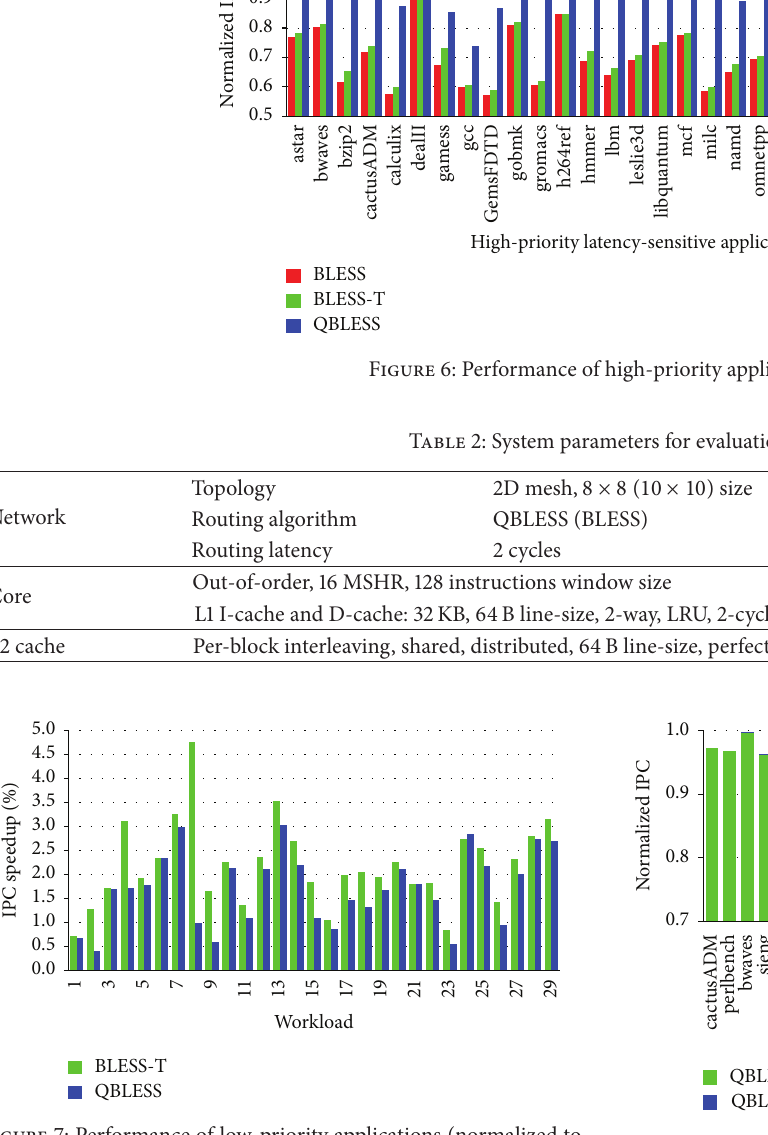
Figure 8: Performance breakdown of routing and congestion control (normalized to